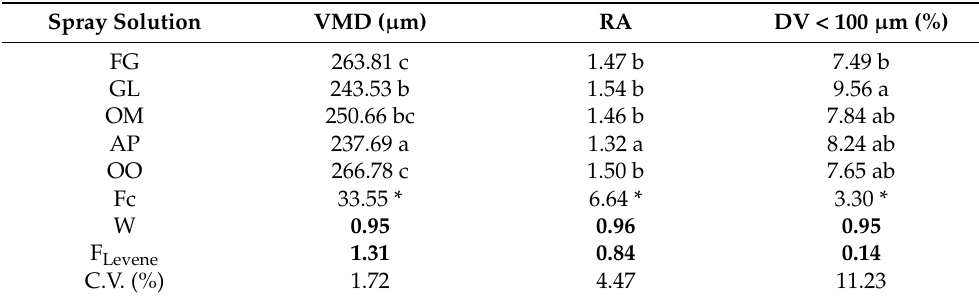
Averages followed by different letters in the columns according to Tukey’s test at 0.05. Fc; W; F Levene : calculated F value; statistics of Shapiro–Wilk and Levene tests, respectively. C.V.: coefficient of variation. Values